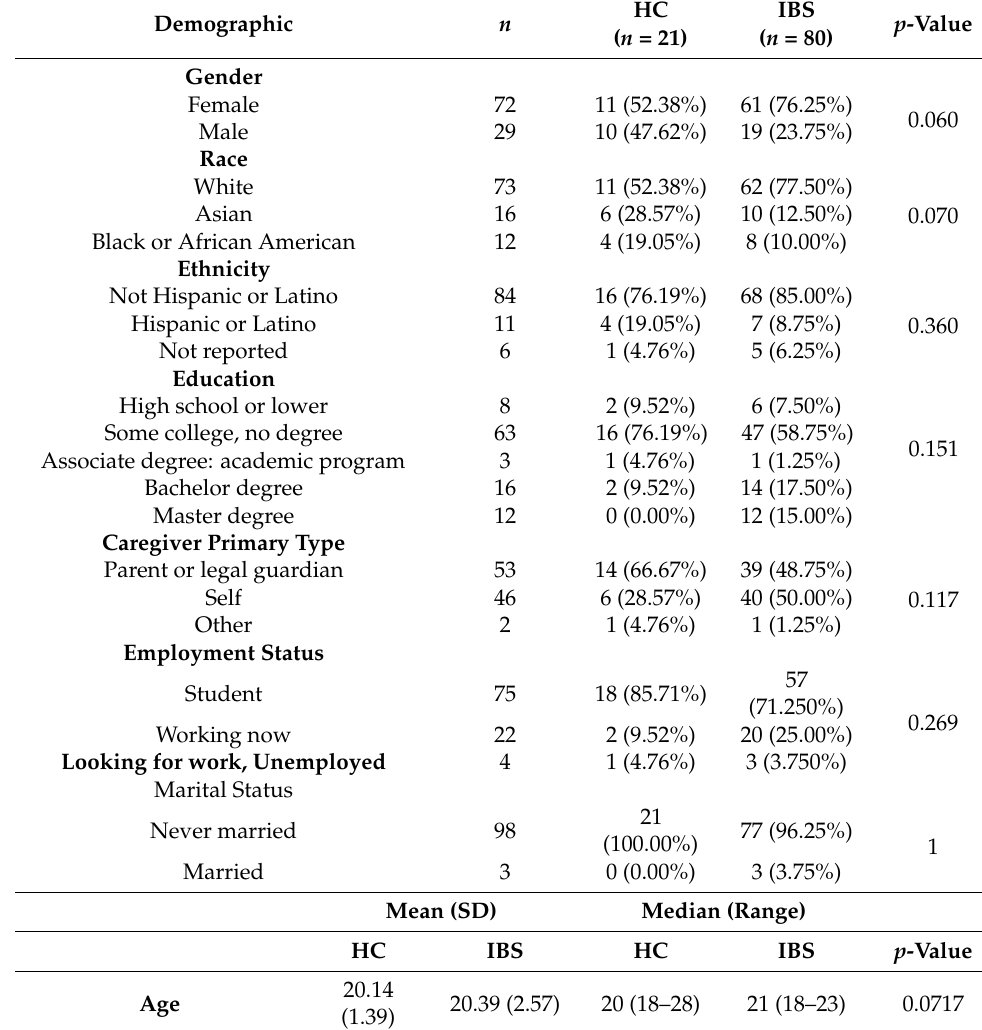
Table 1. Demographic characters in irritable bowel syndrome (IBS) and healthy control (HC)